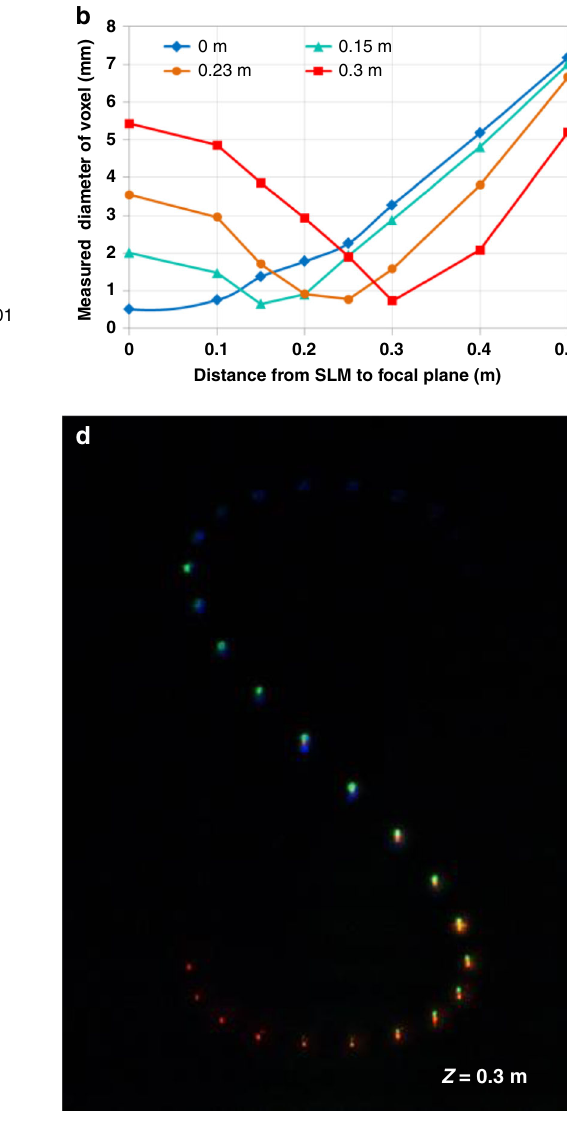
Fig. 5 Measuring the accommodation effect. a The coloured voxels are placed along Z -axis with various X – Y positions where whole voxels can be seen as letter ‘ S ’ . b Measured diameters of each voxels are plotted for different focal planes. c , d The holographic images are taken at the two focal planes of Z = 0 and 0.3 m, respectively. The diameter of blue voxel is the minimum at Z = 0, while the diameter of red voxel is the minimum at Z = 0.3 m, which provides the correct accommodation